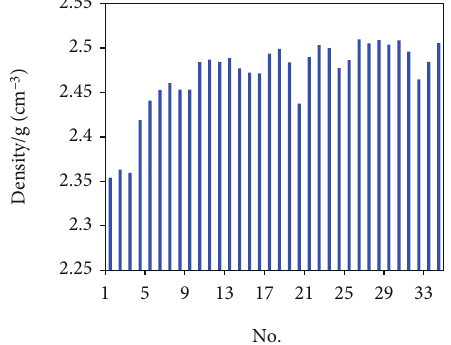
Figure 4: The bulk density of